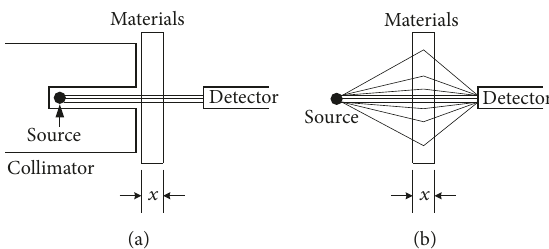
Figure 1: Geometry for gamma-ray attenuation for (a) a narrow beam geometry and (b) a board beam geometry. 𝑥 was the thickness of designed materials.